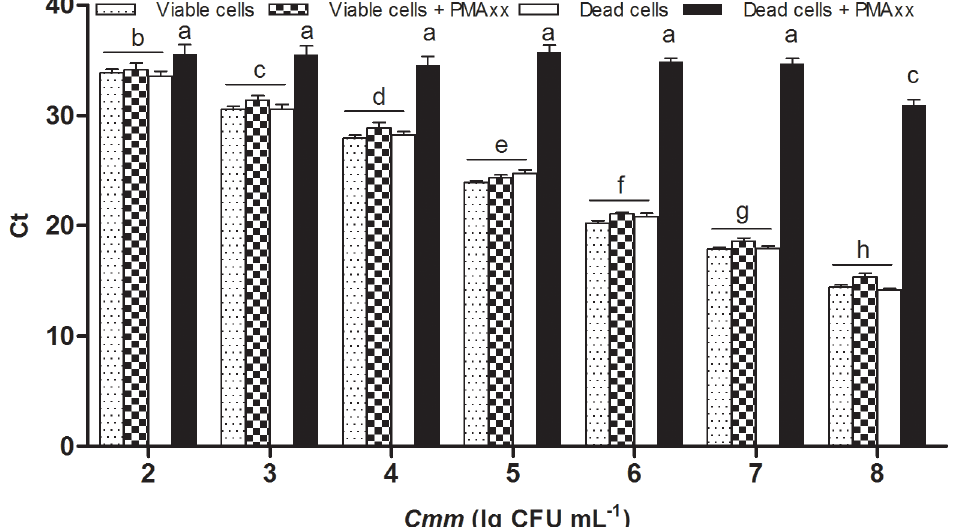
Fig 1. Specificity and sensitivity of PMAxx-qPCR assay in detecting viable cells of Clavibacter michiganensis subsp. michiganensis ( Cmm ). Viable or heat-killed Cmm cells at various concentrations were treated with 20 μ M PMAxx, followed by DNA extraction and qPCR detection. Ct: threshold cycle of qPCR. CFU: colony forming unit. PMA: propidium monoazide. Columns and bars represent mean values and standard deviations. Means followed by different letters are significantly different ( P < 0.05).